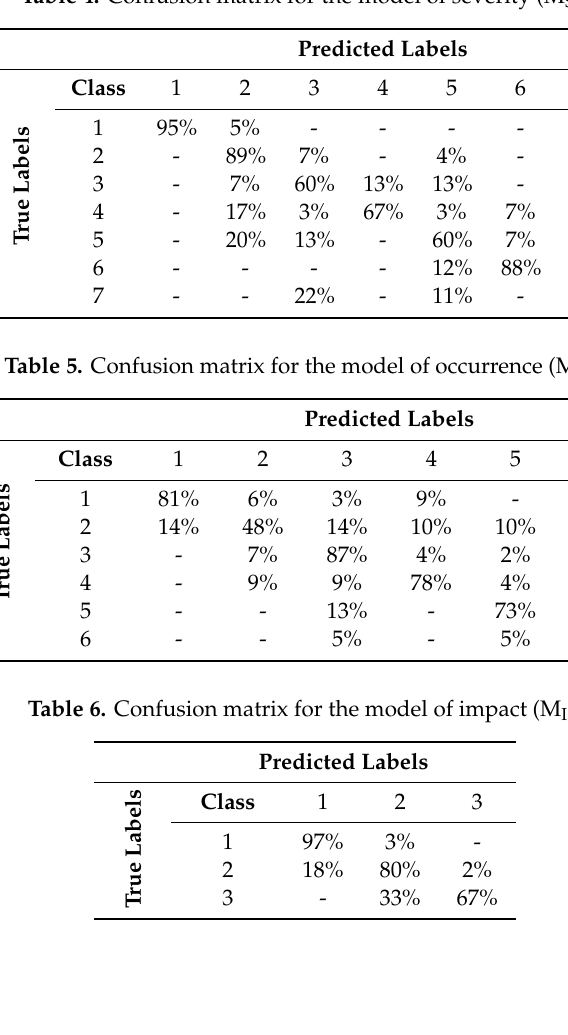
Table 4. Confusion matrix for the model of severity (M S ).